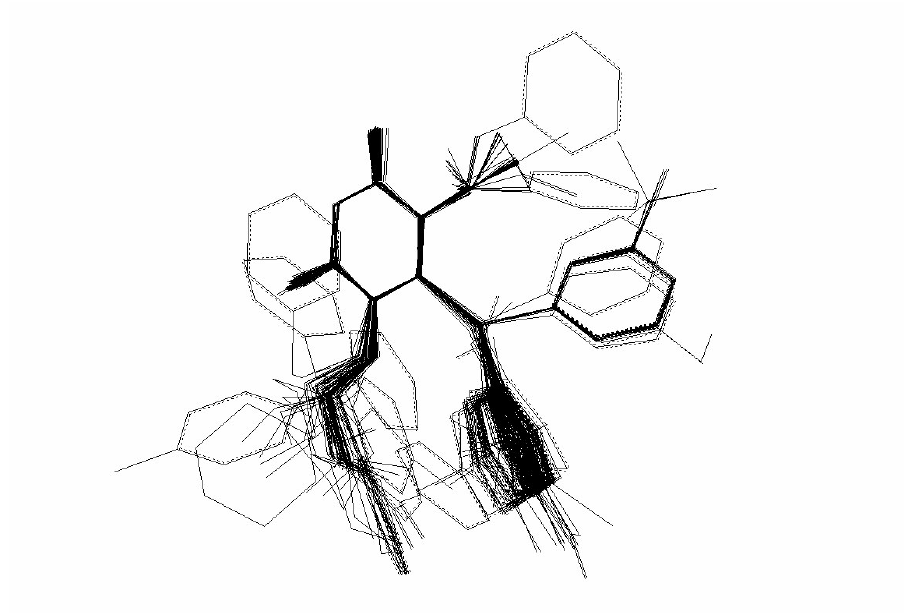
Figure 4. Superposition of the minimum energy conformations of the 79 ligands from Table I.